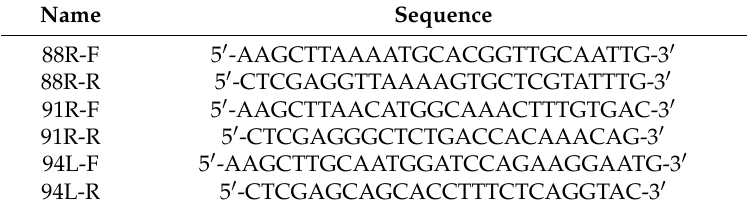
Table 1. Oligonucleotide sequences designed to isolate the conserved genes from the frog virus 3 (FV3) genome. Restriction sites were added 3 base pairs upstream of the start codon ( Hind III—AAGCTT) and in the place of the stop codon ( Xho I—CTCGAG) was added at the 3’ end of each